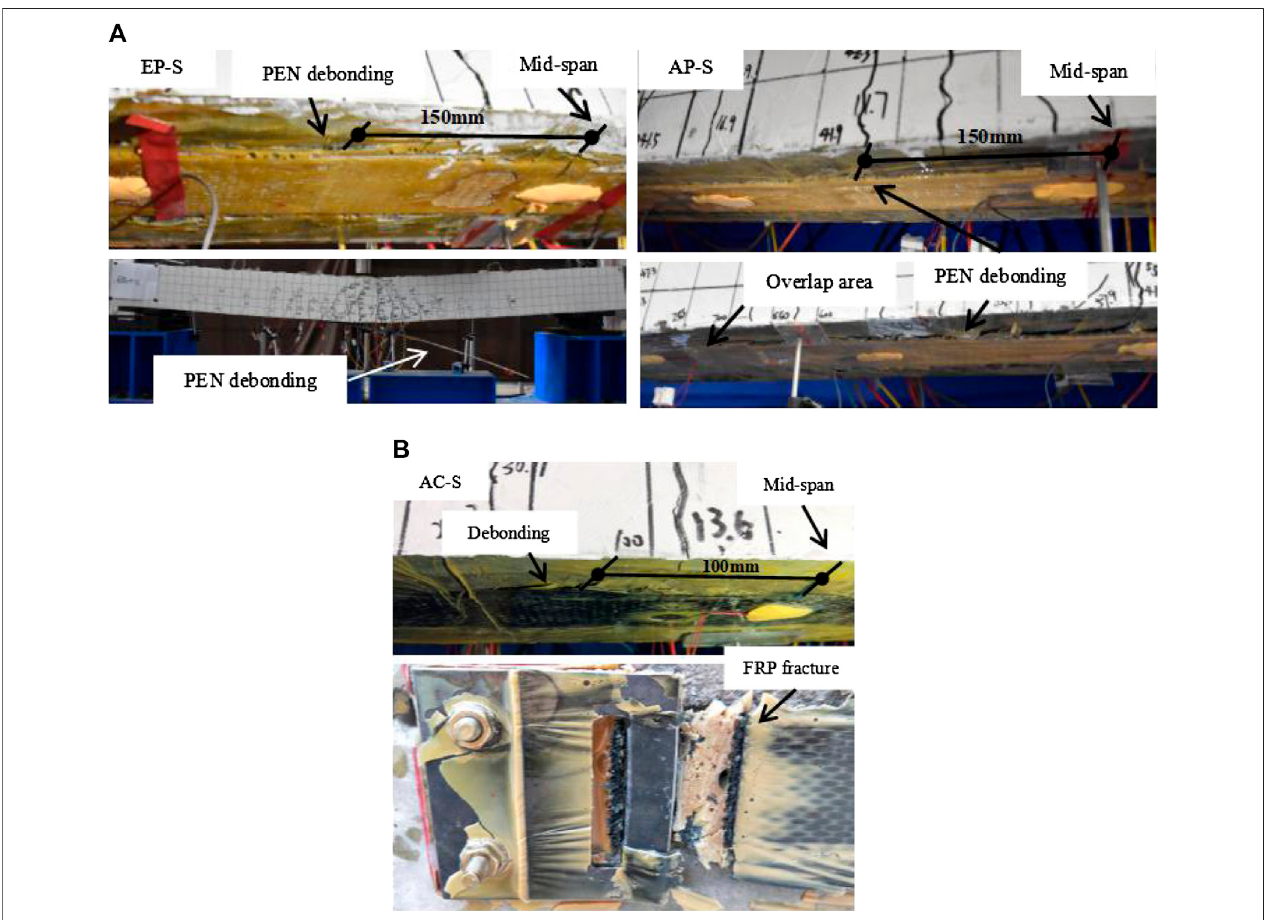
FIGURE 6 | FRP debonding failure patterns in static tests. (A) FRP debonding process of EP-S and AP-S. (B) FRP debonding process of AC-S.